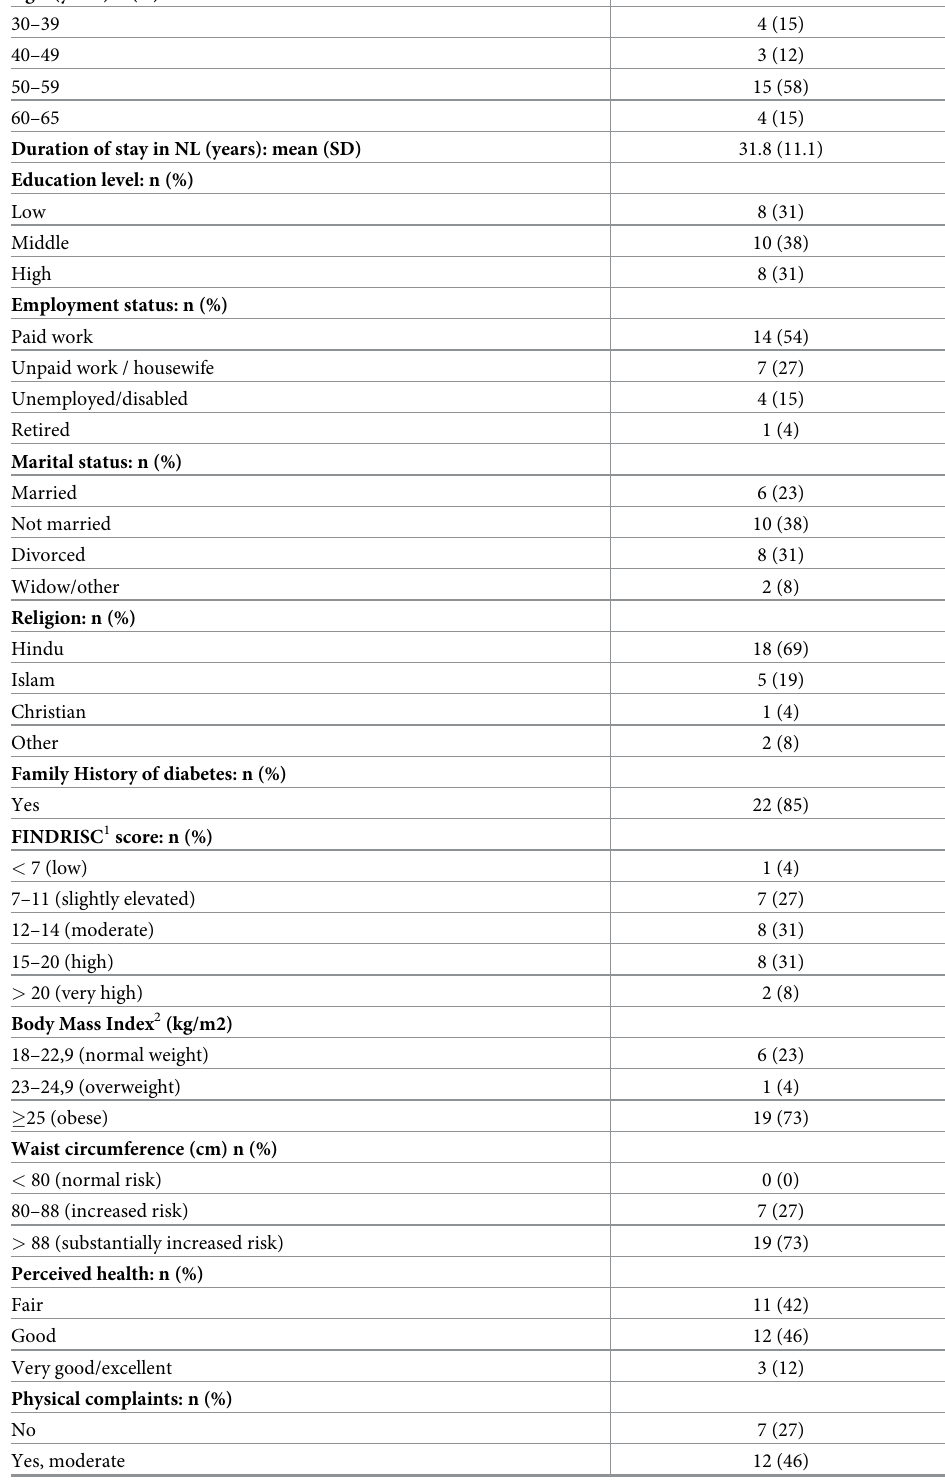
Table 2. Baseline characteristics women of South Asian origin (n =